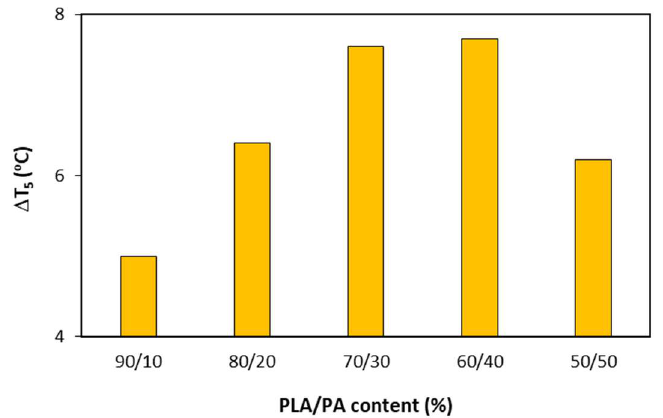
Figure 2. Increase in onset decomposition temperatures ( ∆ T 5 = T 5 REX − T 5 No REX ) when using reactive extrusion for bioblends containing 90–50% of PLA.